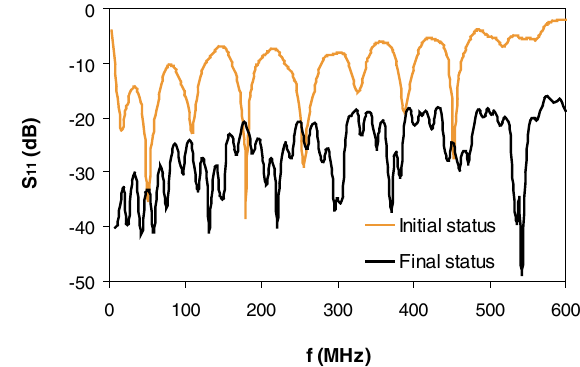
FIG. 17. (Color) Comparison between the initial and final S coefficient of the TW chamber in the significant frequency range.